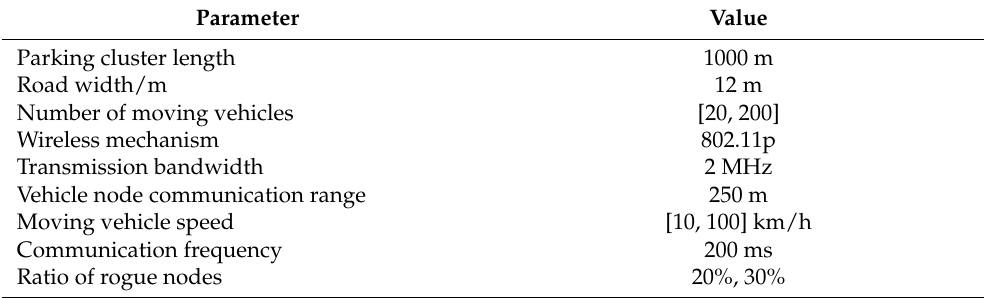
Table 2. Simulation parameters in this